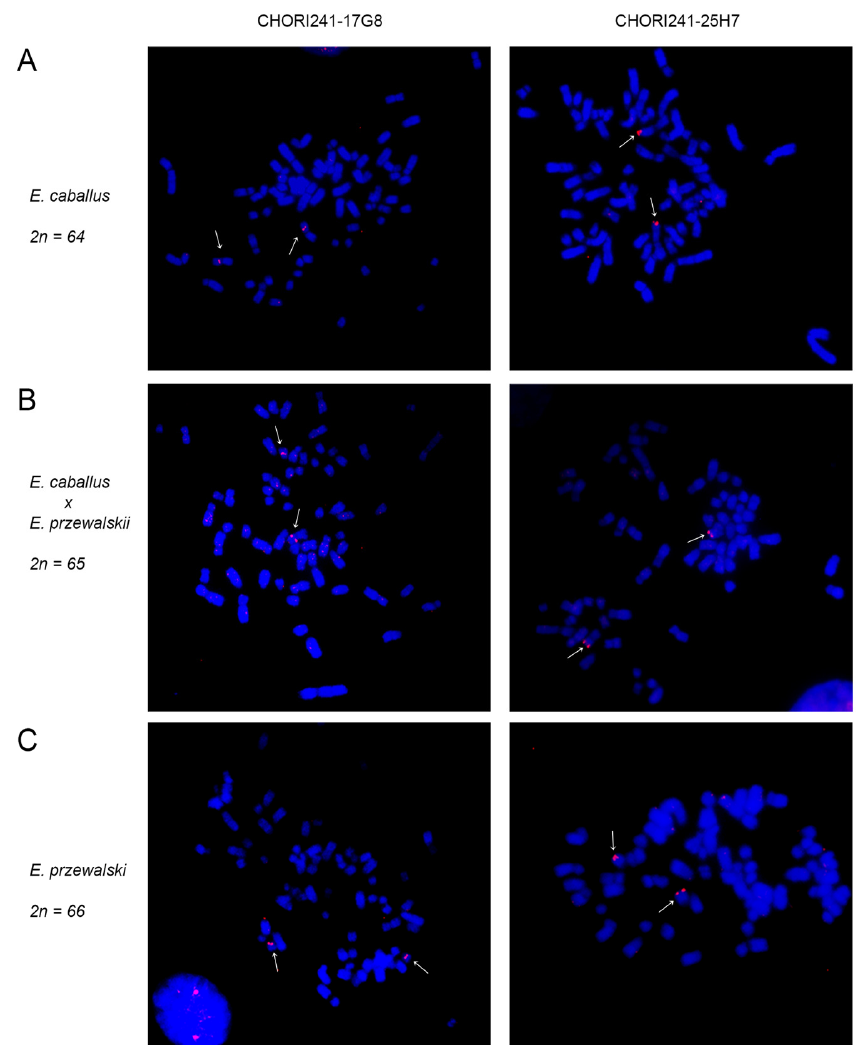
Figure 2. Chromosomal localization of two horse BAC clones specific for ECA5p and ECA5q. Metaphase spreads from E. caballus ( A ), E. caballus × E. przewalskii ( B ), and E. przewalskii ( C ) hybridized with BAC clone CHORI241-17G8 (ECA5p) on the left and BAC clone CHORI241-25H7 (ECA5q) on the right. Chromosomes were stained with DAPI (blue). The white arrows indicate BAC signals (red).